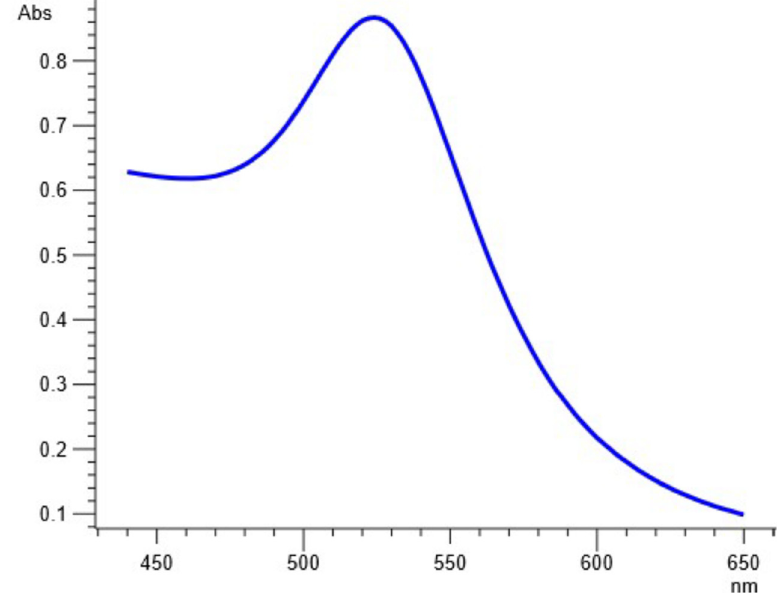
Figure 3. UV-Vis-Spectrophotometric Analysis of the Carduus edelbergii mediated AuNPs.